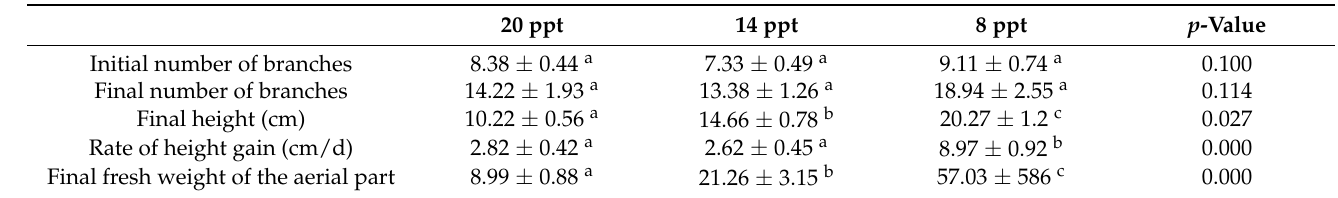
Table 3. Rock samphire’s growth performance during the 45 days of cultivation trials in brackish aquaponics